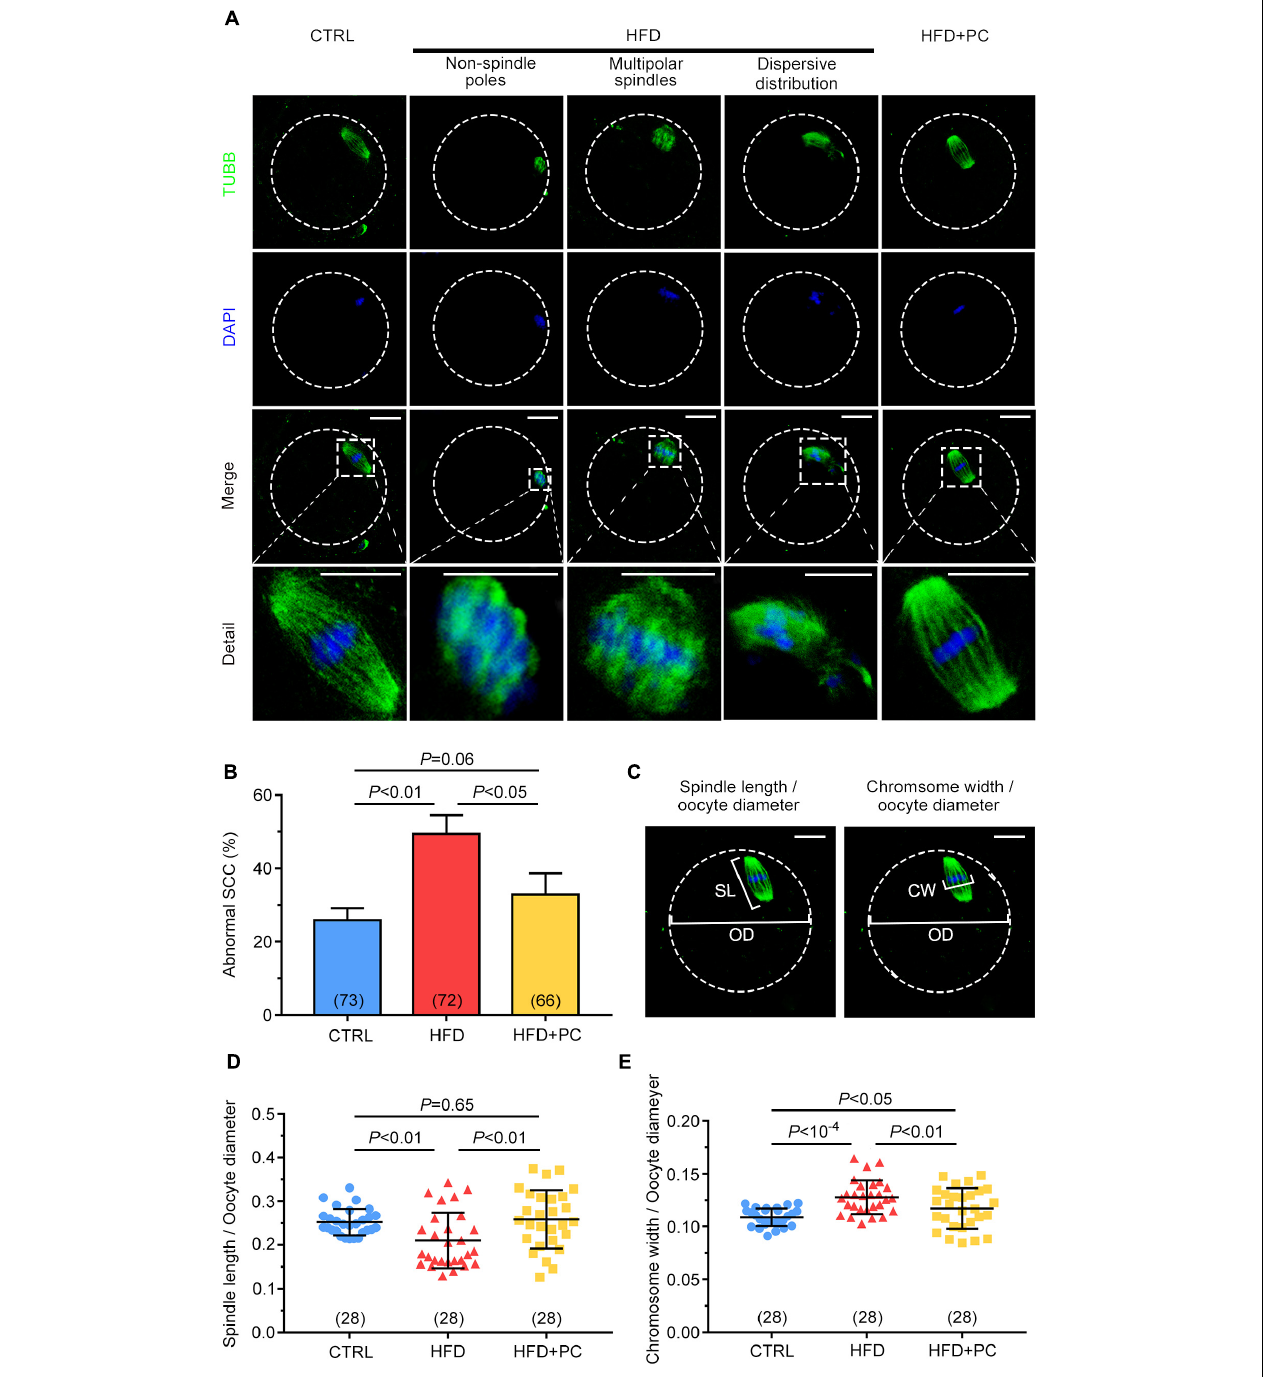
FIGURE 5 | Spindle-chromosome complex (SCC) malformations were reversed after PC administration in obese mice. (A) Representative images of SCCs in MII oocytes. Oocytes in the CTRL group exhibited normal spindles and chromosome condensation (left column). Oocytes in the HFD groups displayed abnormal SCCs (three middle columns). Normal oocyte spindle and chromosome condensation in the HFD + PC group (right column). The circular white frame indicates the oocyte edge and the square white square indicates the region shown in detail. Green, tubulin; blue, DNA. Scale bar = 20 µ m. (B) The ratios of SCC abnormalities in the CTRL, HFD, and HFD + PC groups. (C) Schematic representation of spindle length (SL)/oocyte diameter (OD) (left panel) and chromosome width (CW)/oocyte diameter (OD) (right panel) . Green, tubulin; blue, DNA. The circular white frame indicates the oocyte edge. Scale bar = 20 µ m. (D) Spindle length/oocyte diameter ratios in MII oocytes. (E) Chromosome width/oocyte diameter ratios in MII oocytes. Data are expressed as mean ± SD and were compared by one-way ANOVA and Newman–Keuls post hoc tests. The number of oocytes assessed in each group is shown in parentheses.